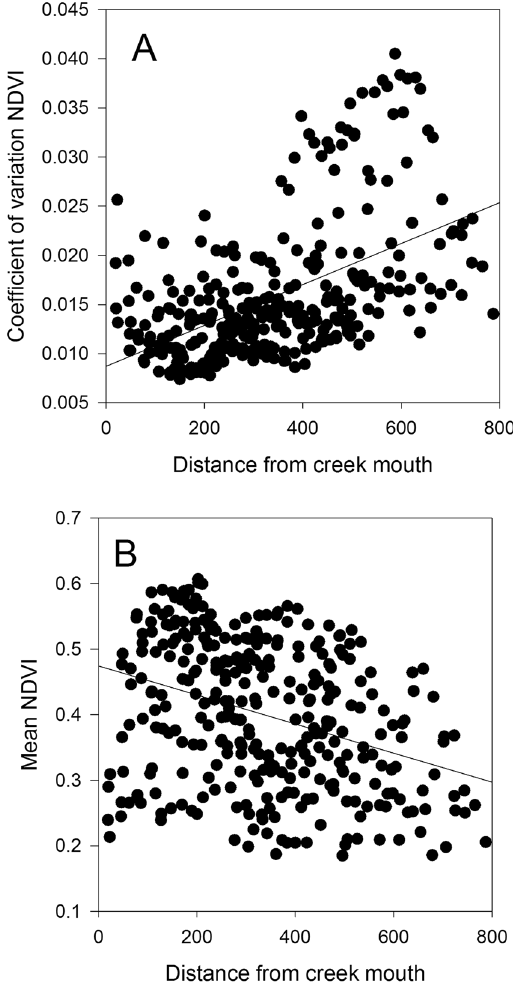
Figure 5. The coefficient of variation in the Normalized Difference Vegetation Index (NDVI) of pixels in the Mangrove Bay mangrove forest ( A ) and the mean NDVI ( B ) as a function of distance from the creek mouth. The regression line in panel A is y = 0.0087 + 0.000021 * x, R 2 = 0.27 (P < 0.0001) and in panel B is y = 0.47 + − 0.000022 * x, R 2 = 0.12 (P <